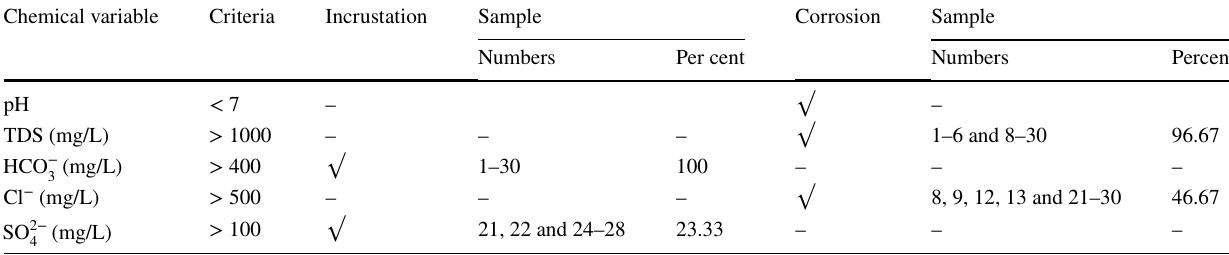
Table 13 Water quality criteria for industry (Anon 1986) Chemical